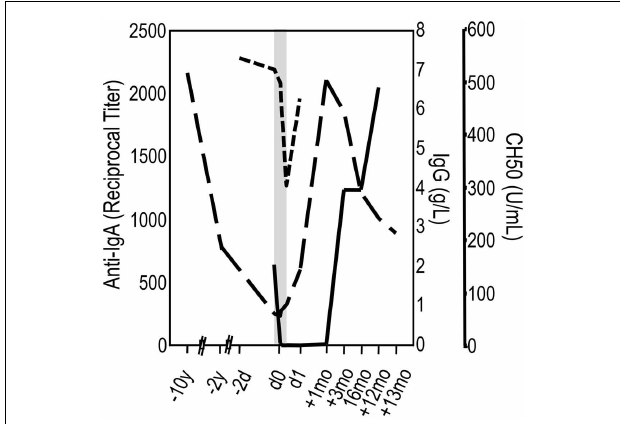
FIGURE 4 |An individual’s slithering into the dark . A female patient has been suffering from recurrent airway infections since adolescence, occasionally complicated by pneumonia. At age 34, selective IgA deficiency was diagnosed.Ten years later, she was hospitalized with pneumonia. Within these 10years, her serum IgG had dropped from 7 to 0.87g/L (long-dashed line) and IgA was undetectable.The diagnosis was corrected into CVID, and IVIG replacement therapy was initiated (shadowed area).Two minutes after the start of the infusion of a 3% IgG solution (IgA<1.2g/L; 3% solution), she experienced a flush, back pain, rigors, difficulty in breathing, and hypotension.The infusion was immediately stopped and later continued without further complications (see text).The confirmation of a true anaphylactoid reaction due to anti-IgA in the serum of the patient was achieved by follow-up of anti-IgA (solid line) and CH50 (short-dashed